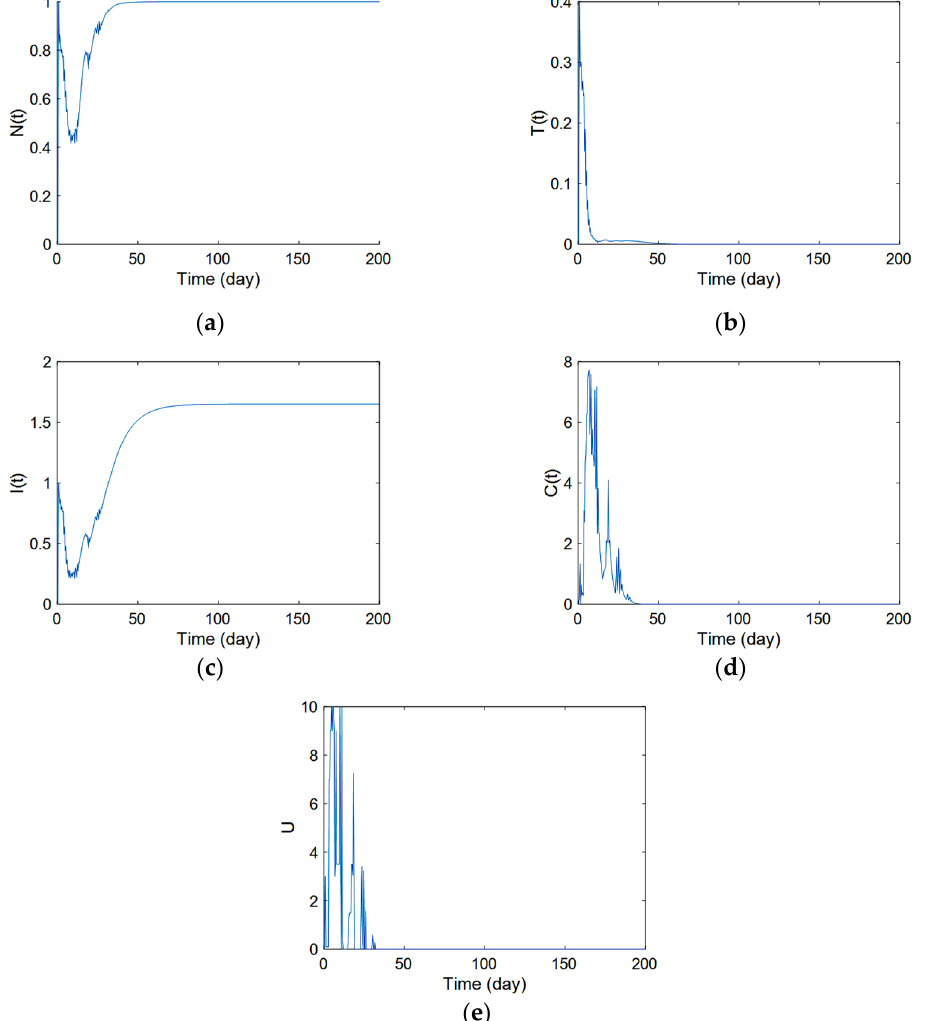
Figure 4. The result of simulation using the proposed control method for young patient without uncertainty. ( a ) Normal-cells ( b ) Tumor-cells ( c ) Immune-cells ( d ) Concentration of cells ( e ) Control action.